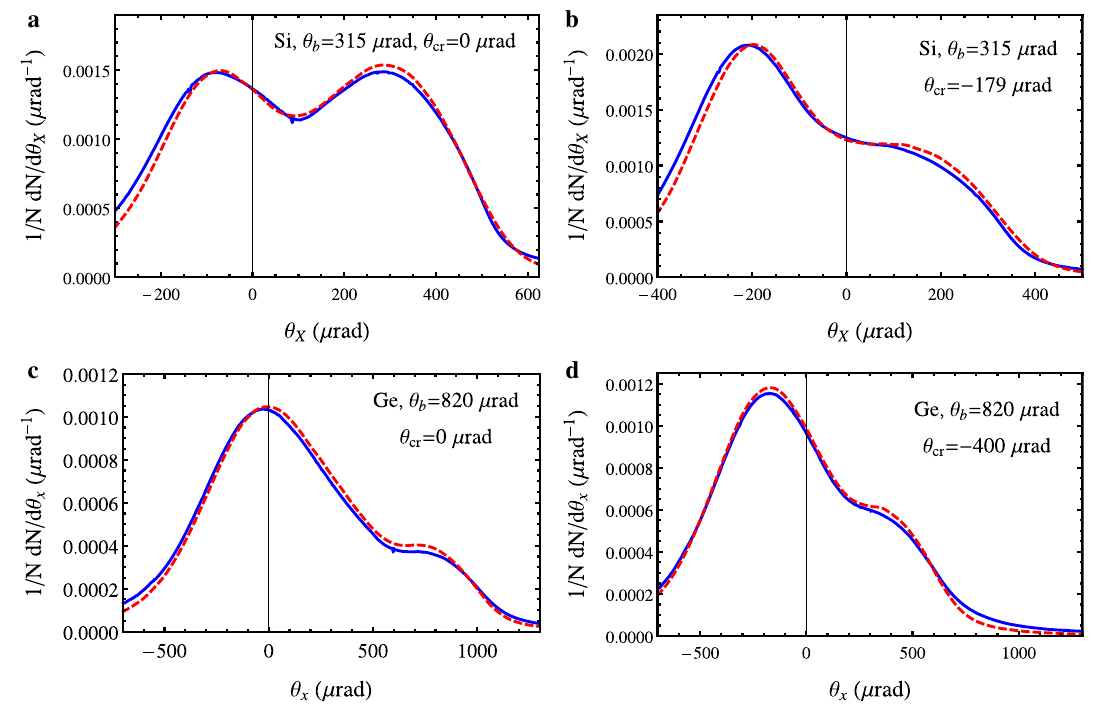
Fig. 4 Experimental (solid) and simulated (dashed) distributions of deflected beam by Si ( a , b ) and Ge ( c , d ) crystals, bent at 315 µ rad and 820 µ rad respectively, for channeling ( a , c ) and volume reflection ( b , d ) crystal alignment. Experimental values represent the projection